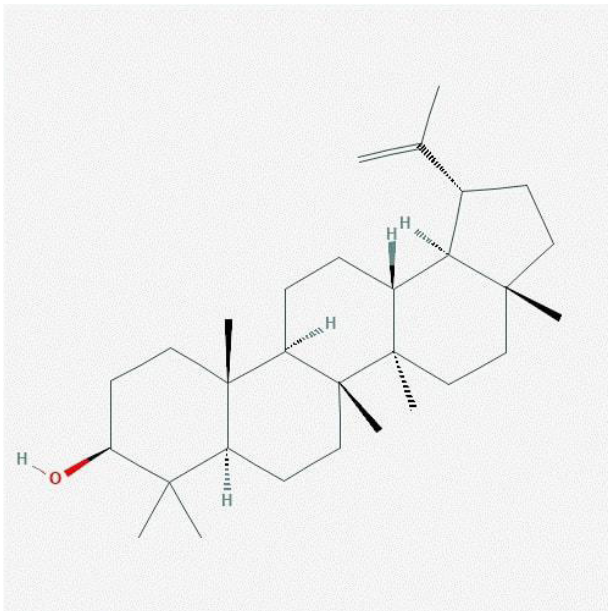
FIGURE 1B - Lupeol is a pentacyclic triterpenoid that is lupane in which the hydrogen at the 3beta position is substituted by a hydroxy group. It has a role as an anti-inflammatory drug and a plant metabolite. It is a secondary alcohol and a pentacyclic triterpenoid. It derives from a hydride of a lupane.